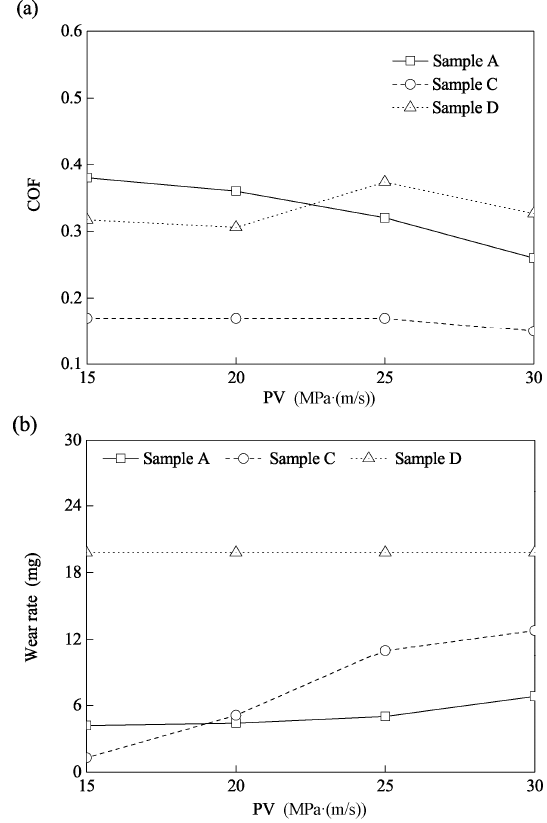
Fig. 13 (a) Average COF and (b) wear rate results with the different materials under the water-lubricated